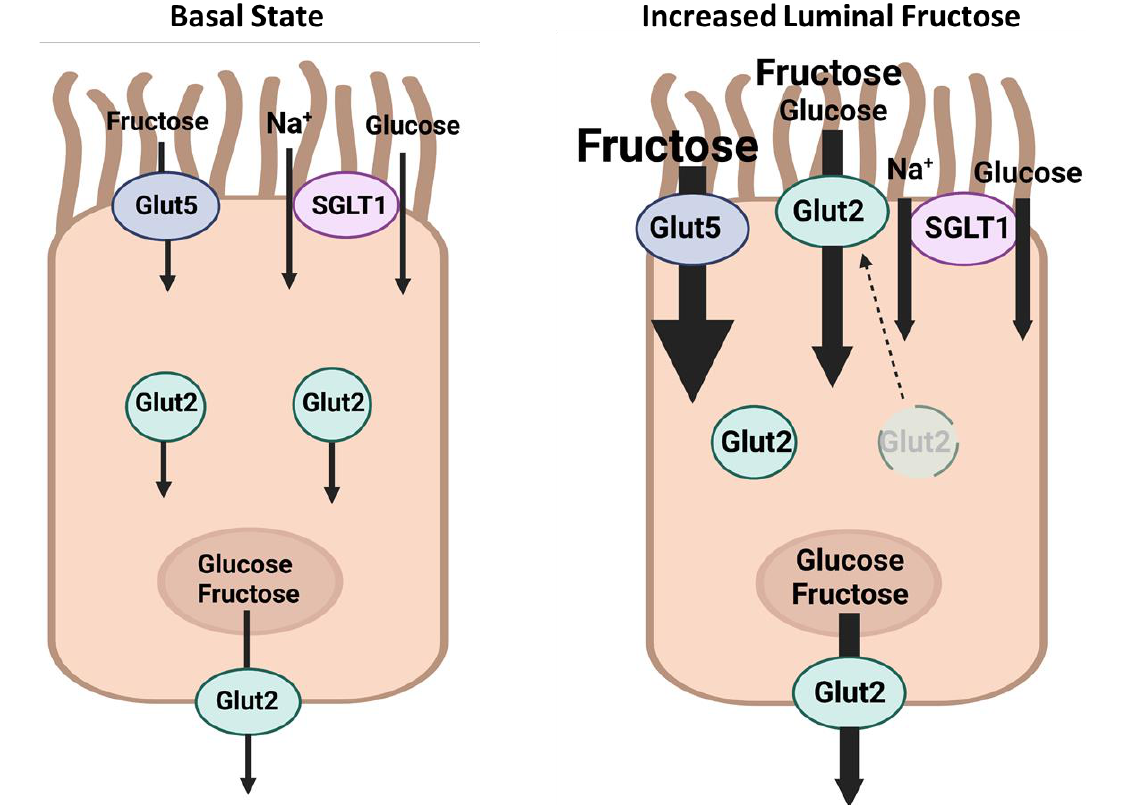
Figure 3. A schematic diagram demonstrating the localization of carbohydrate-absorbing transporters in the small intestine under basal state (left panel) and in the presence of increased luminal fructose (right panel). Glut5 (right panel) has a thickened arrow reflecting its enhanced expression in the presence of increased luminal fructose. SGLT1 (right panel) has a thickened arrow indicating its increased expression and the consequent increase in sodium and glucose transport in the setting of elevated luminal fructose. Glut 2 (right panel) is moved to the apical membrane showing an enhanced absorption of fructose and glucose in the presence of heightened luminal fructose. In addition to increased expression of Glut5 and SGLT1, Glut2 shows increased membrane targeting to the apical membrane in the presence of increased luminal fructose. Created with Biorender.